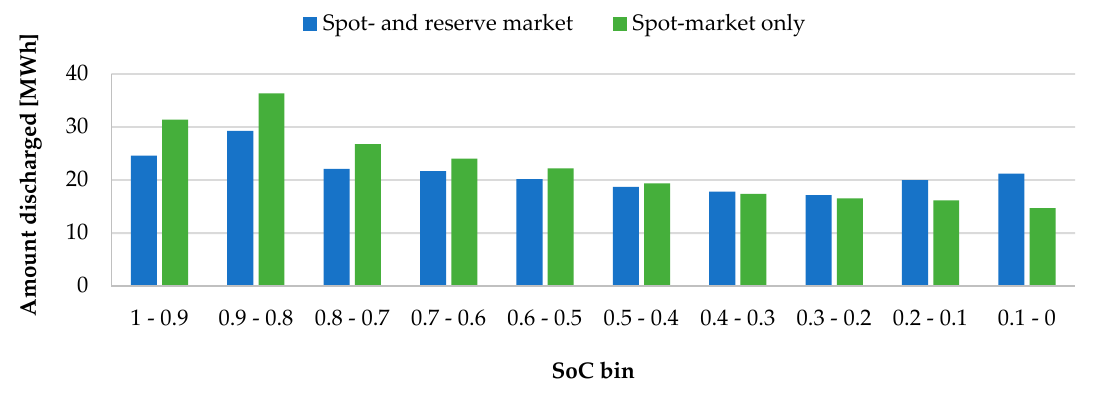
Figure 6. Battery cycling for two scenarios in specific (State of Charge) SoC-bins. Table 5. Electricity charged below or above the recommended